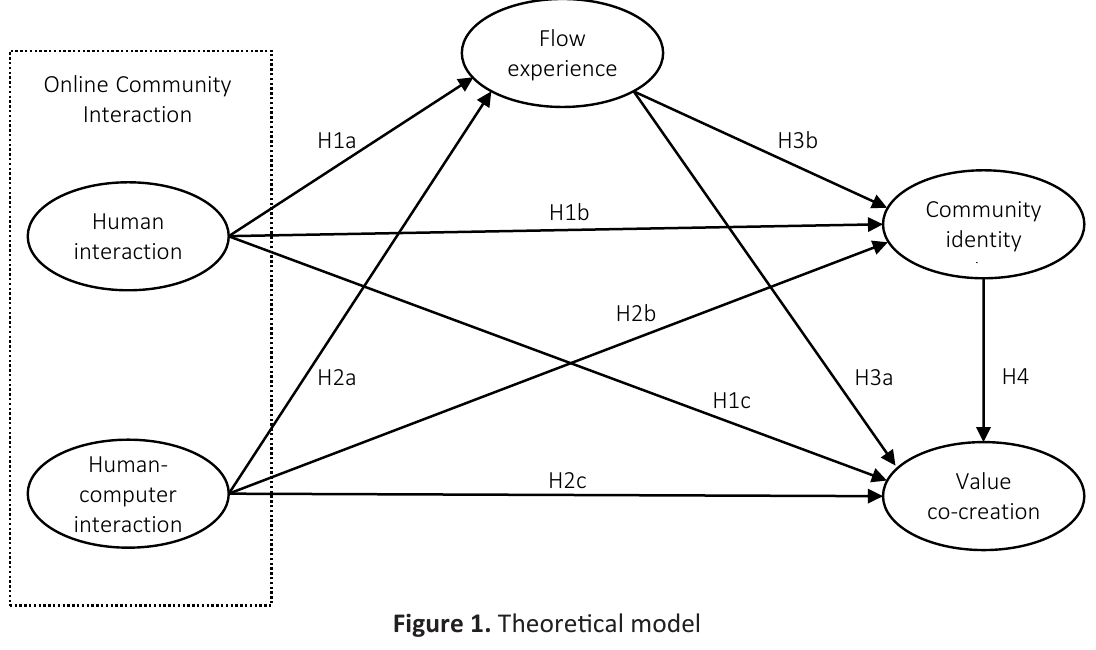
Figure 1. Theoretical